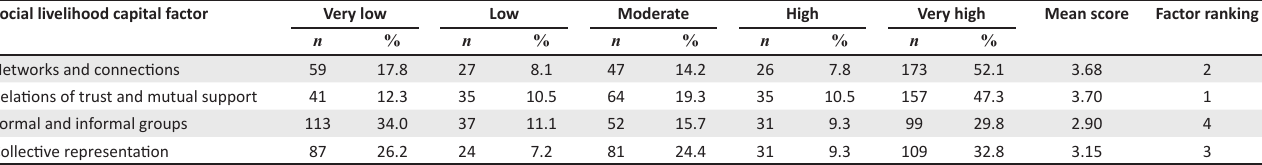
TABLE 4: Ratings of the social livelihood capital factors ( n = 332). Social livelihood capital factor